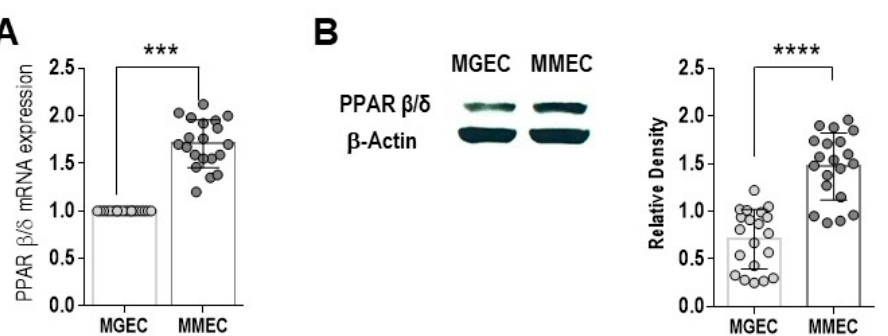
Figure 1. PPAR β / δ expression in bone marrow endothelial cells from MGUS (MGEC) and MM (MMEC) patients. ( A ) Relative mRNA levels of PPAR β / δ in MGEC and MMEC. The values were normalized to those of MGEC and determined by real time-PCR and the 2 − ∆∆ Ct method. ( B ) Western blot and densitometric analysis of the basal expression of PPAR β / δ protein in MGEC and MMEC lysates, normalized to β -actin. The presented values are the mean ± SD from 20 MGUS and 20 MM